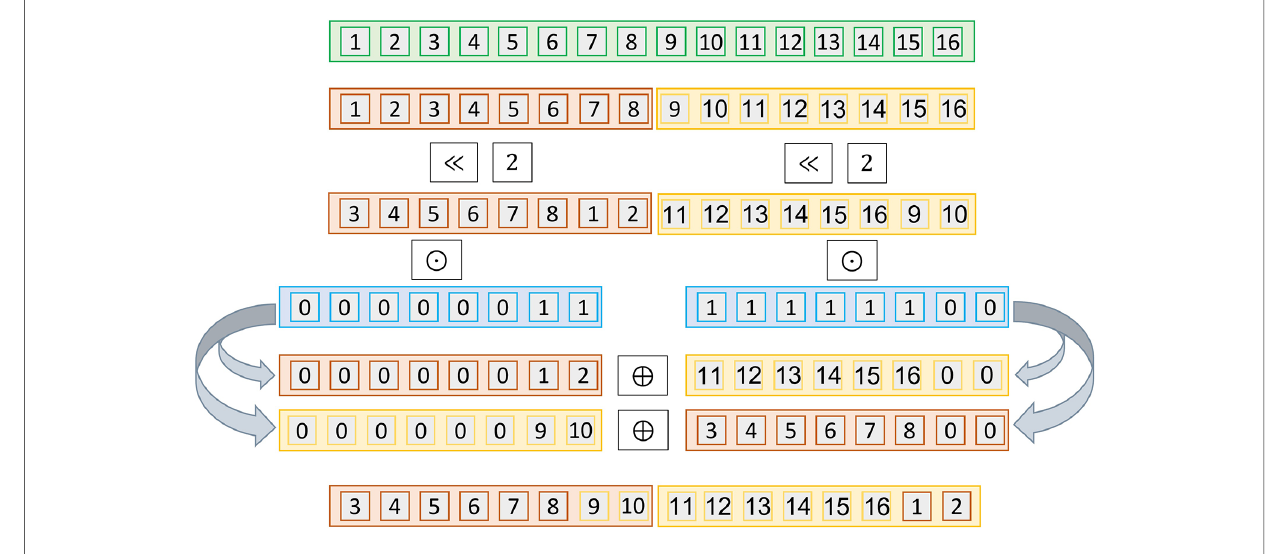
FIGURE 4 Operations performed for privately rotating twice ( ct (cid:7) 2) a vector of dimension n ¼ 16 in with homomorphic encryption ciphertexts of size N ¼ 8 and r ¼ 2. The vector is encoded in two ciphertexts. The ciphertexts need to be rotated, masked and then reorganized to obtain the same result as in the plaintext rotation.